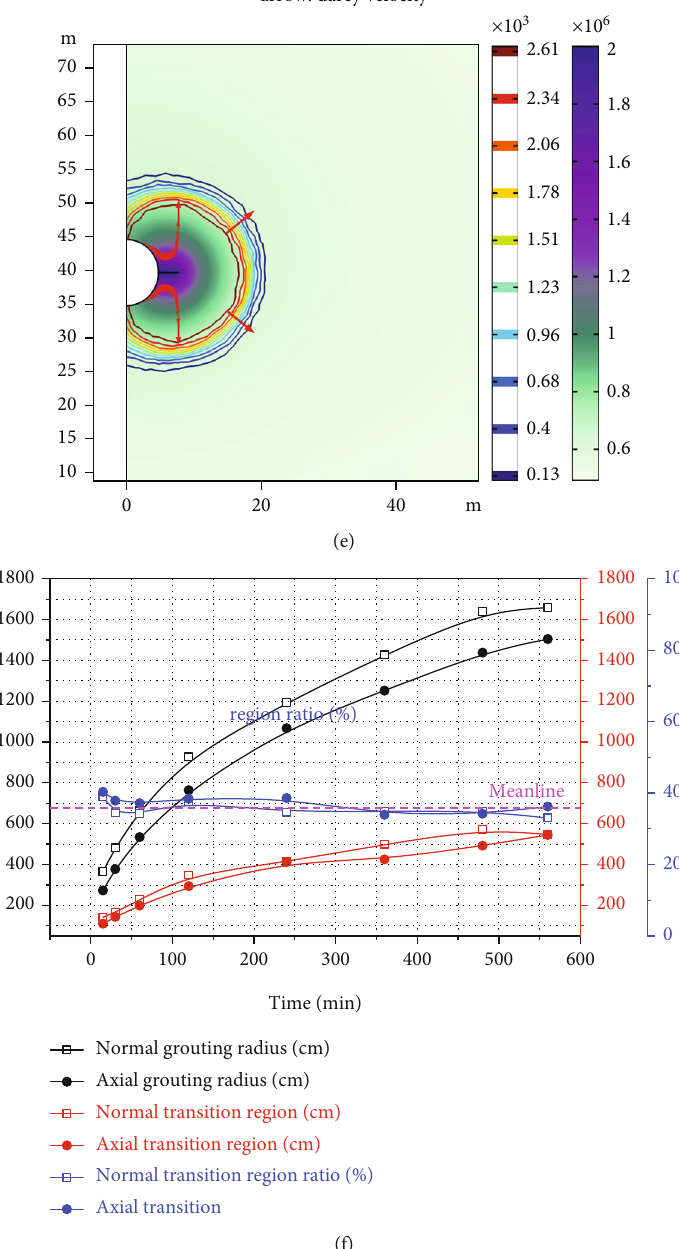
Figure 5: Permeability characteristics of the model with a grouting pressure of 2 MPa and an initial permeability of 5 D. (a) Distribution characteristics of Darcy velocity at di ff erent times; (b) distribution characteristics of viscosity at di ff erent times; (c) distribution characteristics of molar concentration at di ff erent times; (d) distribution characteristics of permeability coe ffi cient at di ff erent times; (e) distribution characteristics of pressure, molar concentration, and Darcy velocity at 420th minute; (f) grouting radius and transition region in di ff erent directions at di ff erent